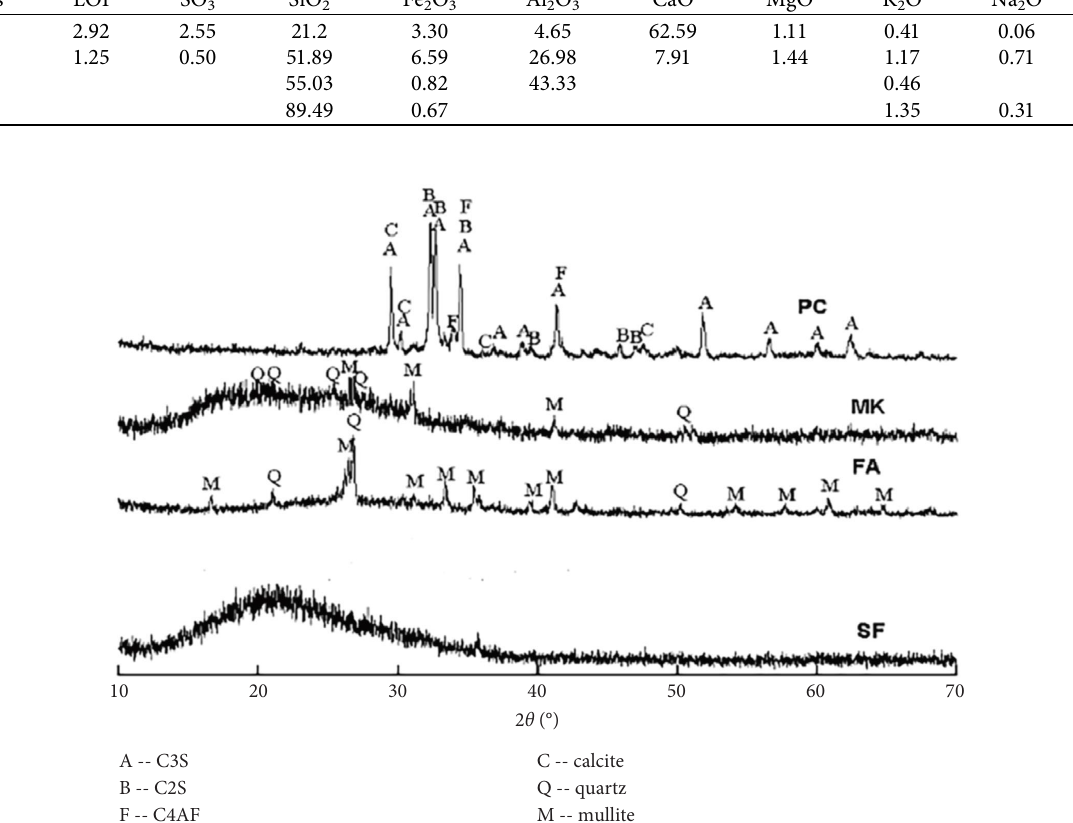
Figure 2: X-ray difraction patterns of cement, MK, FA, and